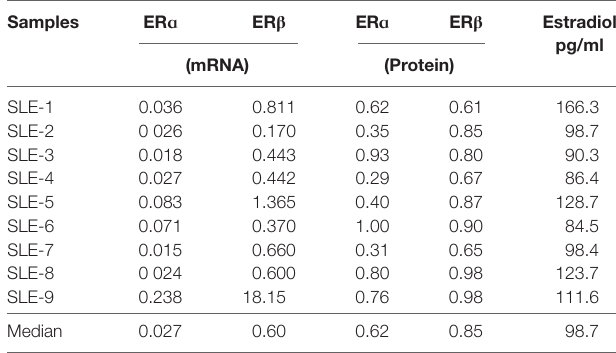
TaBle 5 | Measurements of ER subtype mRNA and protein in freshly isolated systemic lupus erythematosus (SLE) T cells. samples